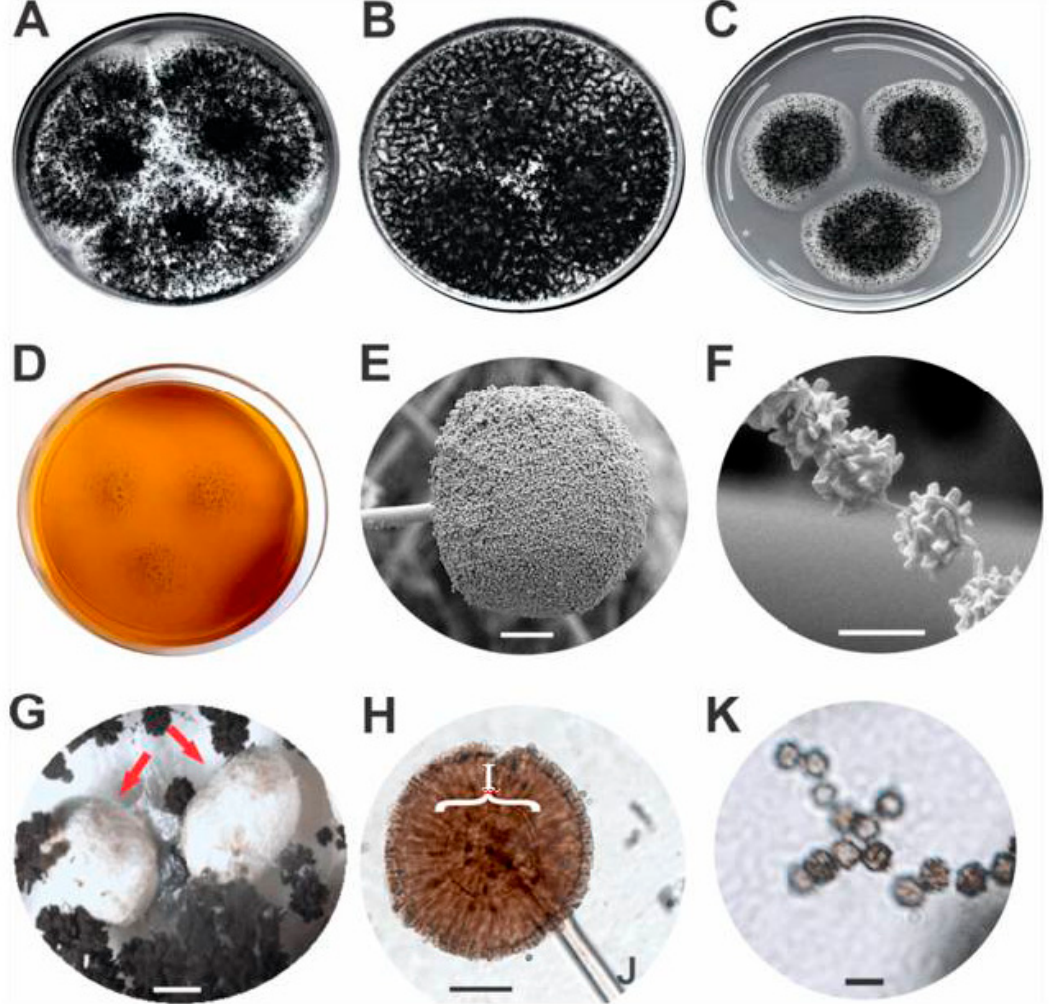
Figure 4. Aspergillus vinaceus sp. nov. MB 833399 ( = ITAL 47.456, = IBT 35556): ( A ) Colonies on CYA (Czapek Yeast Autolysate agar), ( B ) colonies on YESA (Yeast Extract Sucrose Agar), ( C ) colonies on MEA (Malt Extract Agar), ( D ) colonies on CREA (Creatine Sucrose Agar). Scanning Electron Microscopy: ( E ) conidiophore (scale bar 50 µ m), ( F ) conidia (scale bar 5 µ m). Optical Microscopy: ( G ) sclerotia (scale bar 500 µ m) were indicated using red arrows, ( H ) conidiophore, ( I ) vesicle, ( J ) stipe (scale bar 50 µ m), ( K ) conidia (scale bar 5 µ m).